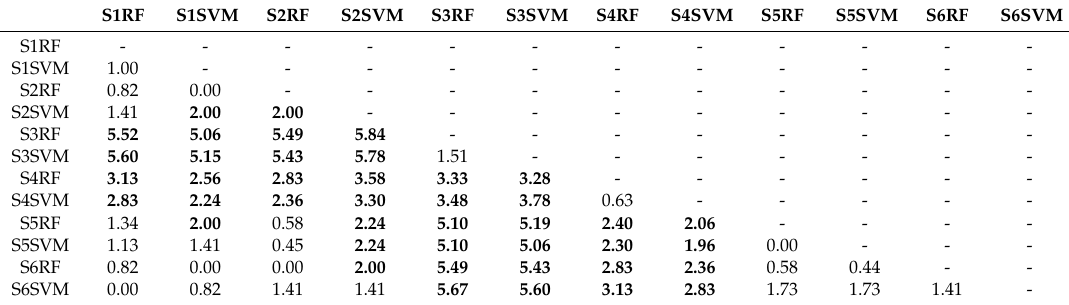
Table 7. Summary of McNemar test results (|z|-values) of binary classifications for site B. The best classification for scheme 1 was used. |Z|-values are in bold if significantly different using α =